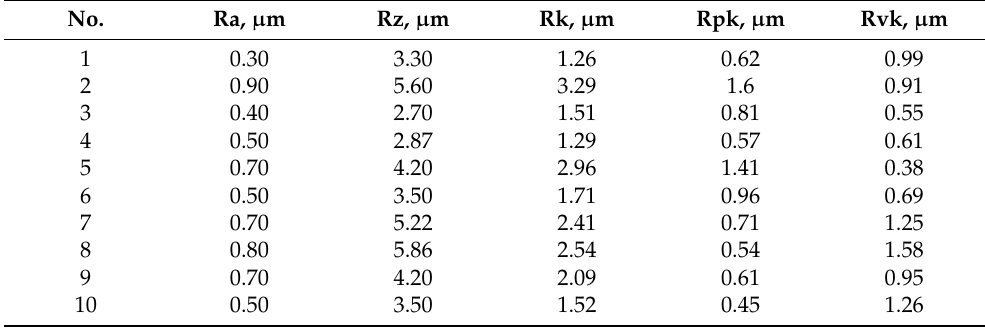
Table 2. The roughness parameters for alloy coatings for surface after turning samples inserts according to the study